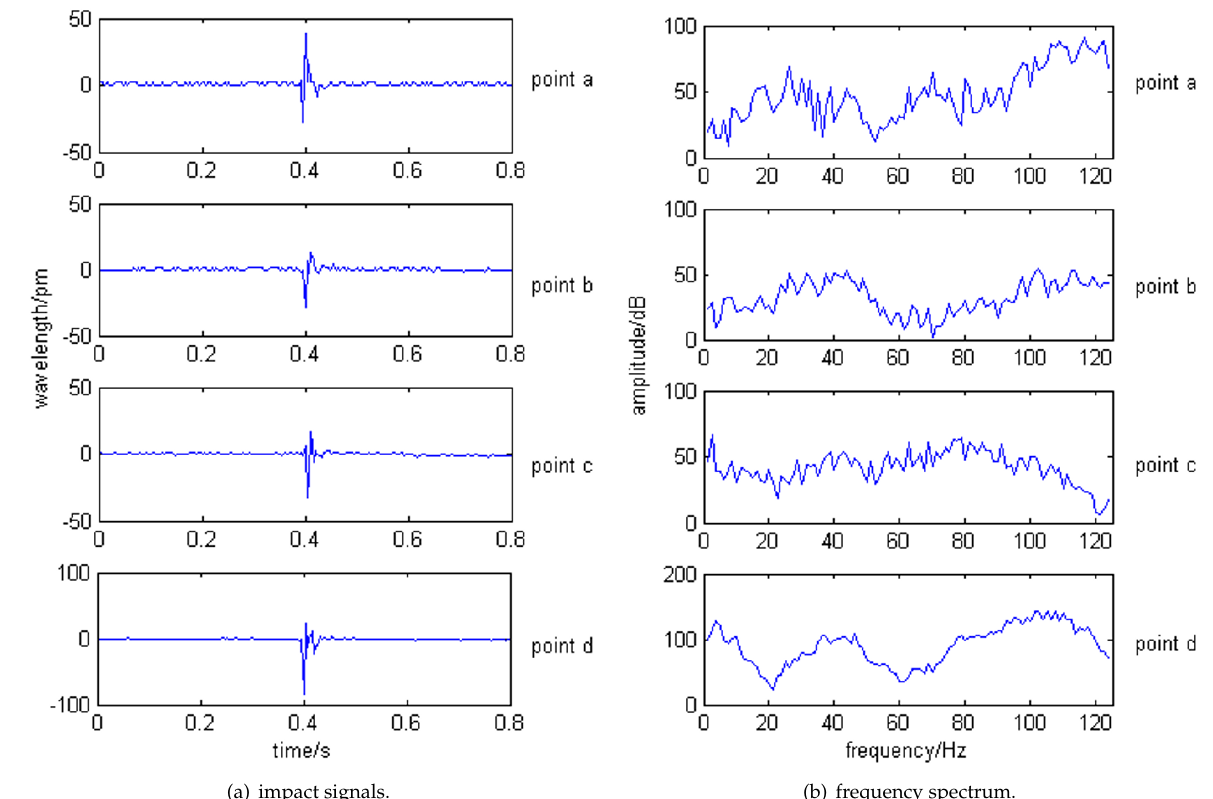
Figure 6. Impact response signals and spectrogram of sensor No. 5 with 2